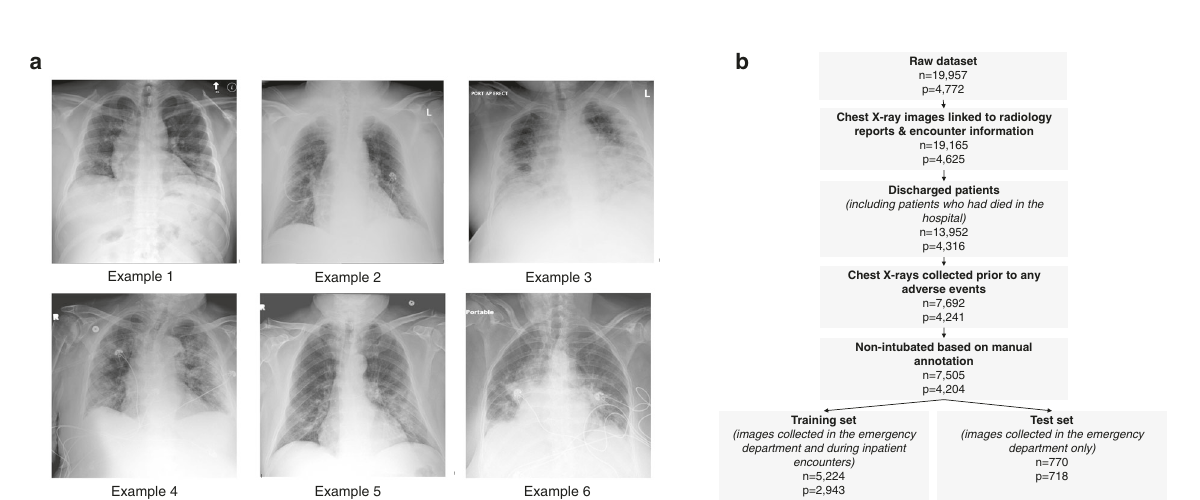
Fig. 2 Illustrations of the dataset and the dataset fl owchart. a Examples of chest X-ray images in our dataset. Example 1: Patient was discharged and experienced no adverse events (44 years old male). Example 2: Patient was transferred to the ICU after 95 h (71 years old male). Example 3: Patient was intubated after 72 h (66 years old male). Example 4: Patient was transferred to the ICU after 48 h (99 years old female). Example 5: Patient was intubated after 24 h (74 years old male). Example 6: Patient was transferred to the ICU in 30 min (73 years old female). It is important to note that the extent of parenchymal disease does not necessarily have a direct correlation with deterioration time. For example, Example 5 has less severe parenchymal fi ndings than Examples 3 and 4, but deteriorated faster. b Flowchart showing how the inclusion and exclusion criteria were applied to obtain the fi nal training and test sets, where n represents the number of chest X-ray exams, and p represents the number of unique patients. Speci fi cally, we excluded 783 exams that were not linked to any radiology report, nine exams that had missing encounter information, and 5213 exams from patients who were still hospitalized by May 13, 2020. To ensure that our system predicts deterioration prior to its occurrence, we excluded 6260 exams that were collected after an adverse event and 187 exams of already intubated patients. The fi nal dataset consisted of 7502 chest X-ray exams corresponding to 4204 unique patients. We split the dataset at the patient level such that exams from the same patient exclusively appear either in the training or test set. In the training